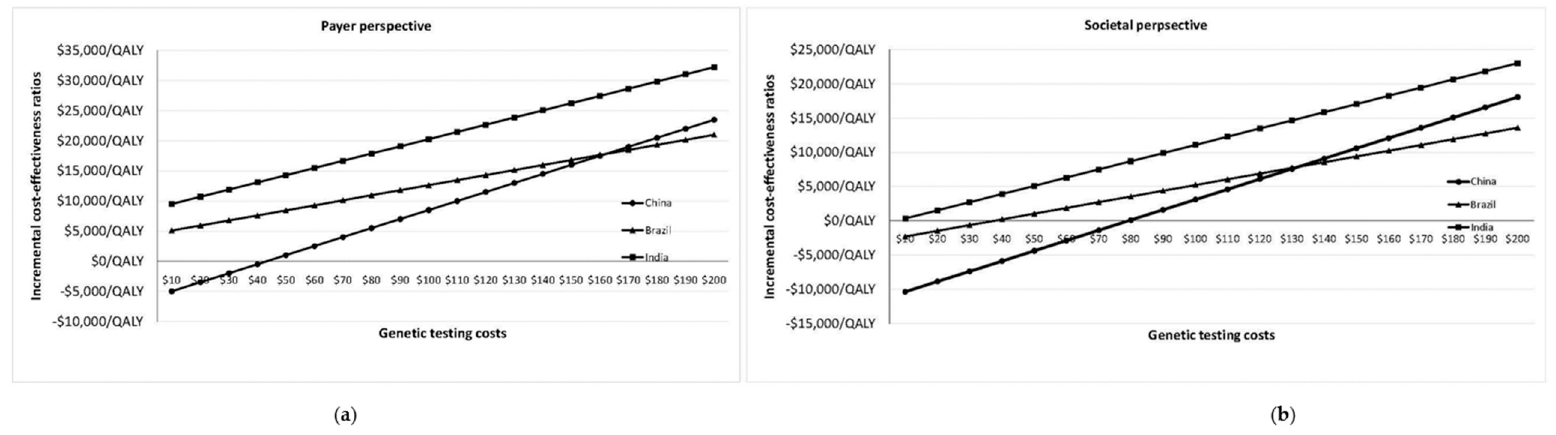
Figure 1. Change in ICER / QALY with varying BRCA testing costs in Brazil, China, and India. ( a ) Change in ICER / QALY with varying BRCA testing costs in Brazil, China and India from a payer / healthcare perspective. ( b ) Change in ICER / QALY with varying BRCA testing costs in Brazil, China, and India from a societal perspective. The graphs depict the change in ICER / QALY at varying costs of BRCA testing for Brazil, China, and India from payer (Figure 1a) and societal (Figure 1b) perspectives. X axis: BRCA testing costs in US$; Y axis: ICER / QALY. Table 1. Baseline analysis.